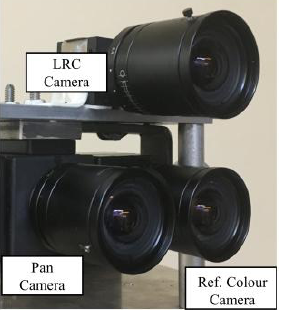
Figure 3: LRC, Pan and reference colour camera (HRC) used in this study. Table 1: Technical specifications of the cameras used in